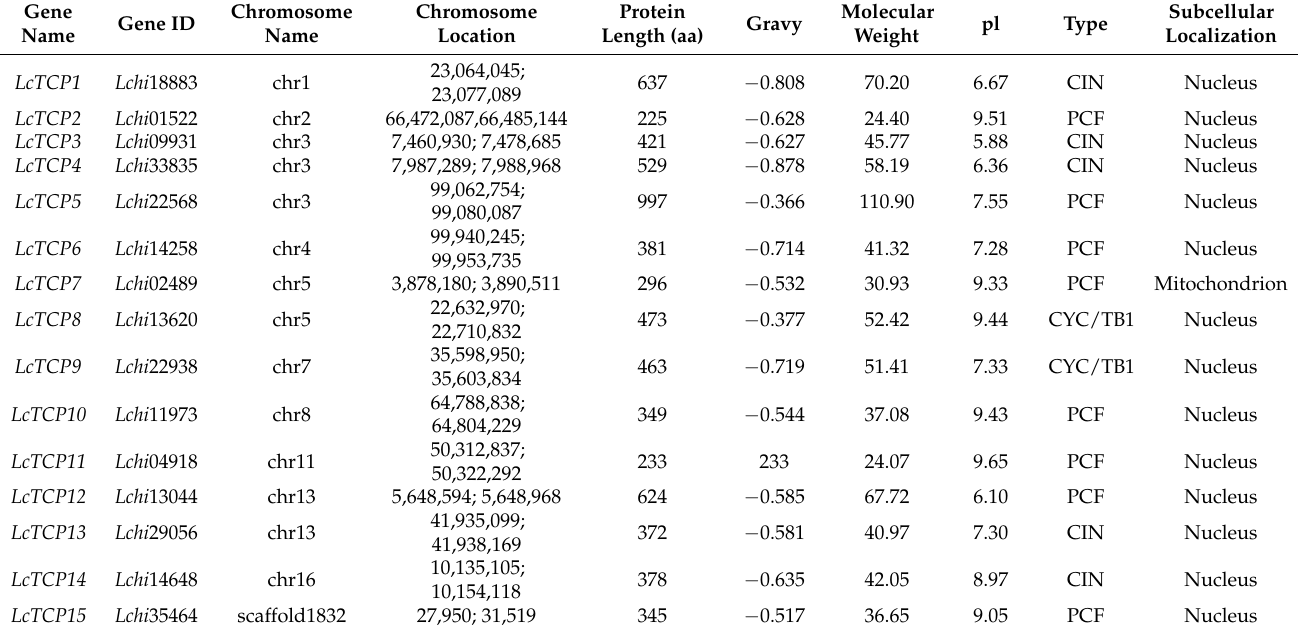
Table 1. Physio-chemical properties of 15 identified Liriodendron chinense